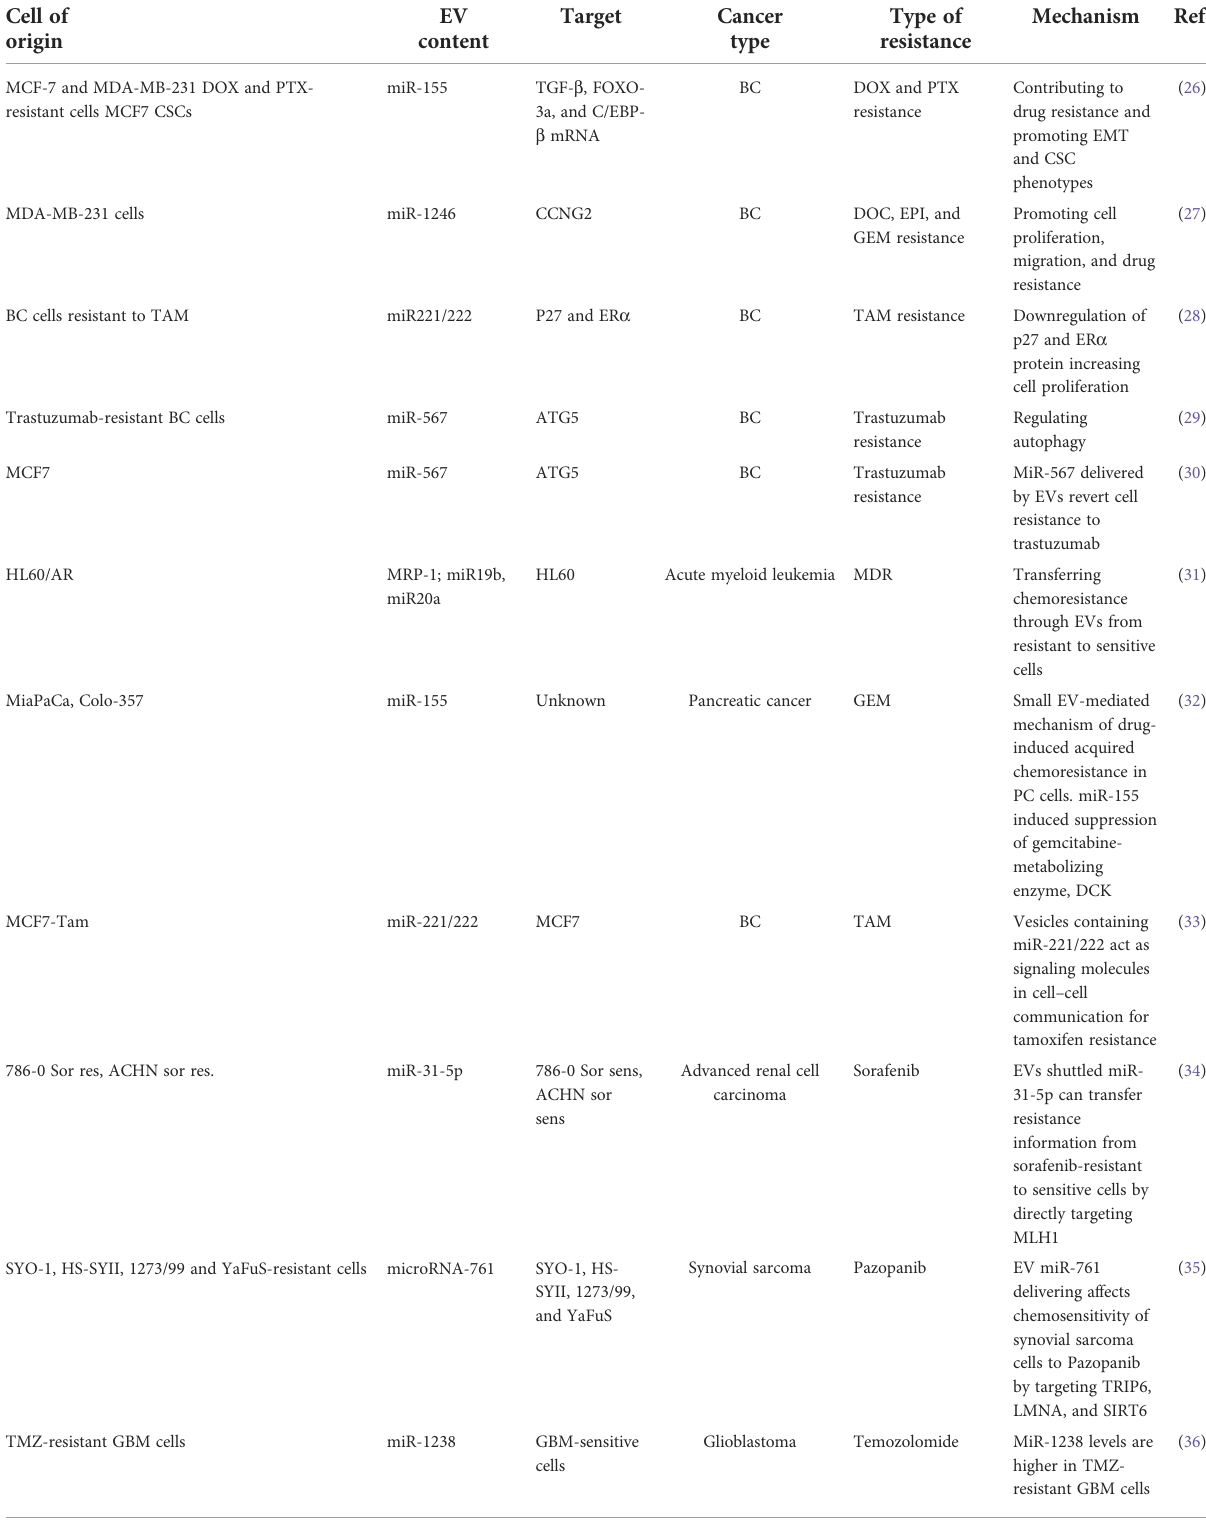
TABLE 1 EVs cargoes and drug resistance mechanisms. miRNA Cell of